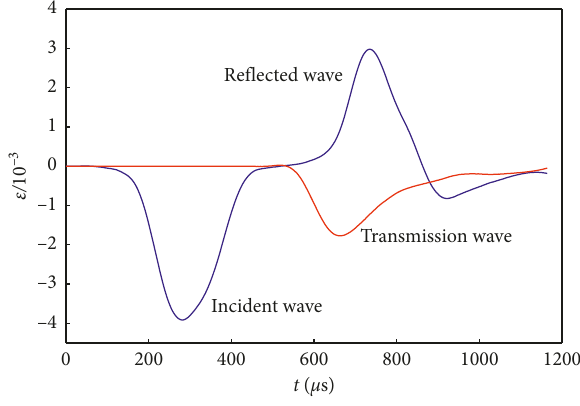
Figure 5: The shock signal of SHPB test.